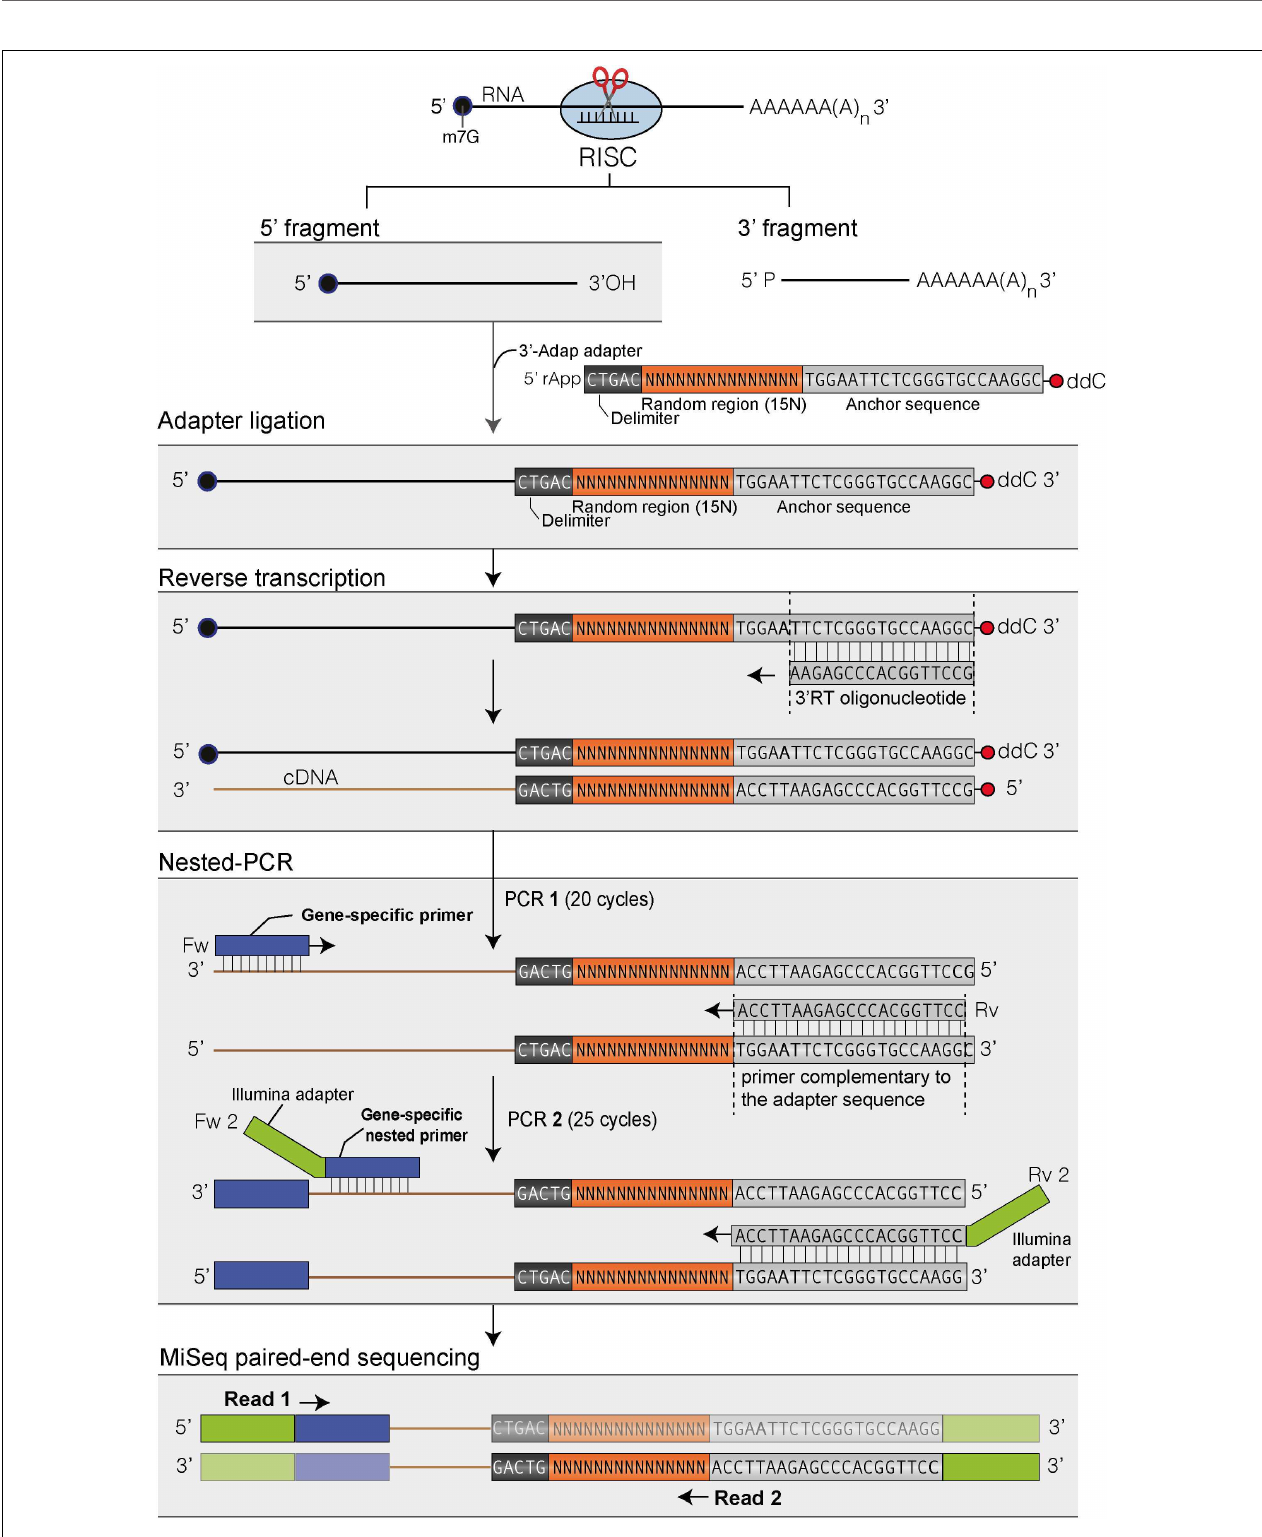
FIGURE 1 | Flowchart of the main steps to map the 3 (cid:48) ends of RISC 5 (cid:48) -cleavage fragments by 3 (cid:48) RACE-seq. Features of the 3 (cid:48) adapter and the principle of the main steps are indicated. The experimental workflow begins by ligating the 3 (cid:48) adapter to the RISC 5 (cid:48) -cleavage fragment. Please note that any RNA molecule with a 3 (cid:48) hydroxyl end in the total RNA sample is ligated to the 3 (cid:48) adapter. The target of interest is specifically amplified during PCR-1 and -2 due to the gene-specific sequences of the forward primers. The protocol is detailed in Methods and the scripts used to analyze data are given in Supplementary Data Sheets S1 , S2 .